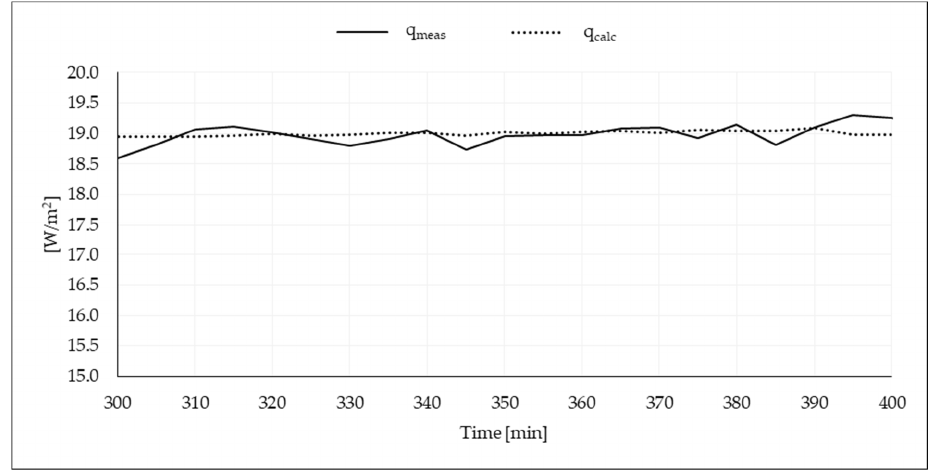
Figure 9. Comparison of measured ( q meas ) and calculated ( q calc ) heat flow density.